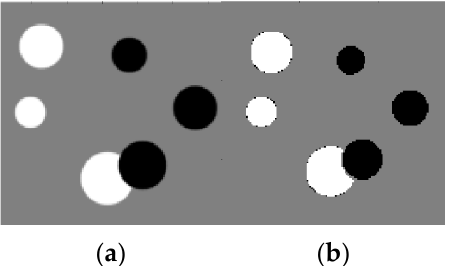
Figure 7. Reconstruction of a circle’s image based on qualitative data. ( a ) Original image; ( b ) Recon- Figure 7. Reconstruction of a circle's image based on qualitative data. ( a ) Original image; ( b ) Recon- Figure 7. Reconstruction of a circle's image based on qualitative data. ( a ) Original image; ( b ) Recon- Figure 7. Reconstruction of a circle's image based on qualitative data. ( a ) Original image; ( b ) Recon- structed image. structed image. structed image. structed image.